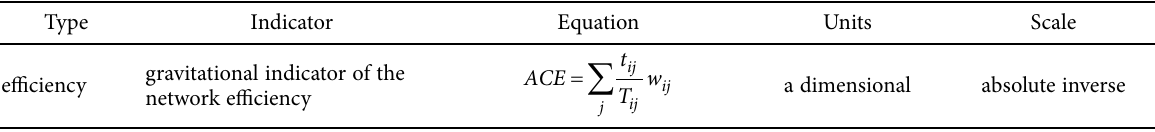
Table 3. Efficiency accessibility